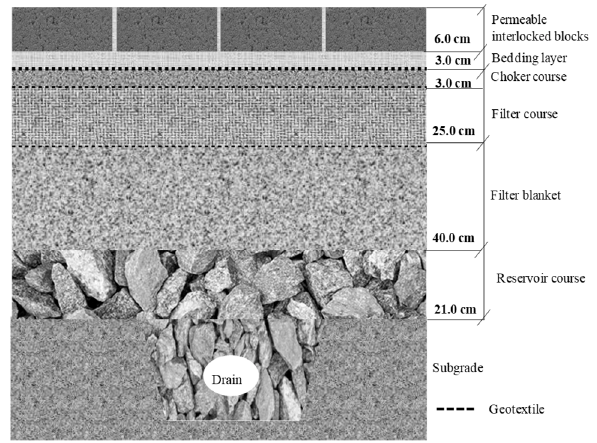
Figure 4. Cross-section of the permeable pavement structure (based on [32,33]).